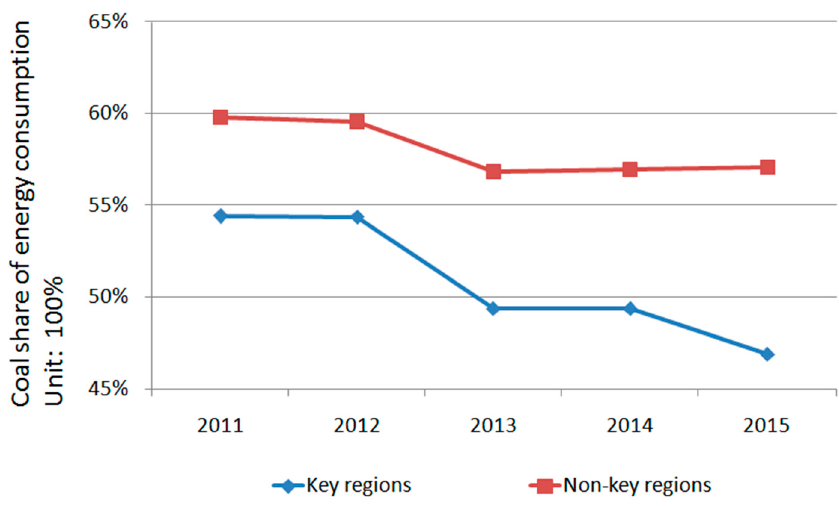
Figure 3. Comparing coal share between key and non-key regions.